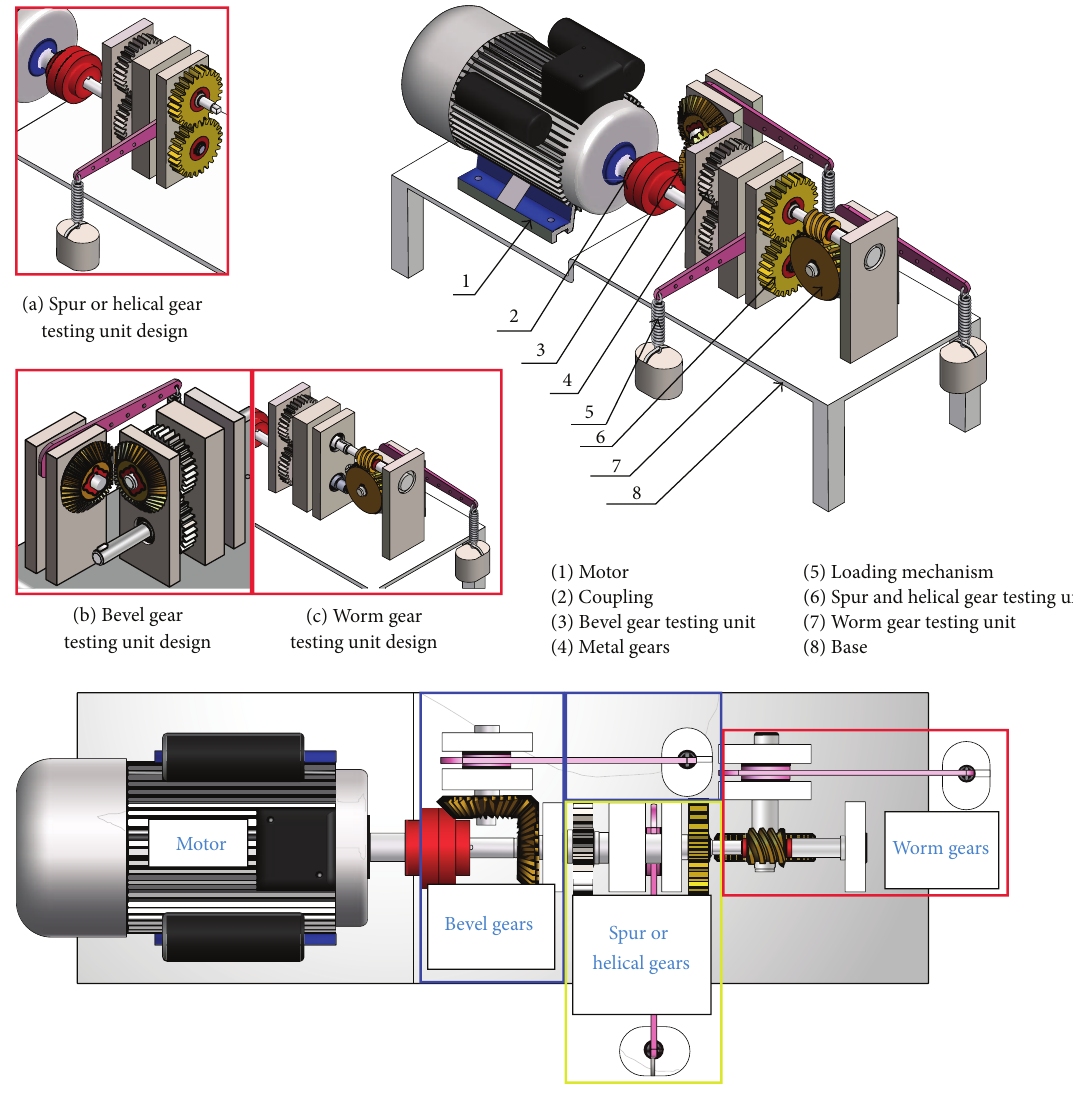
Figure 3: Universal test rig design.